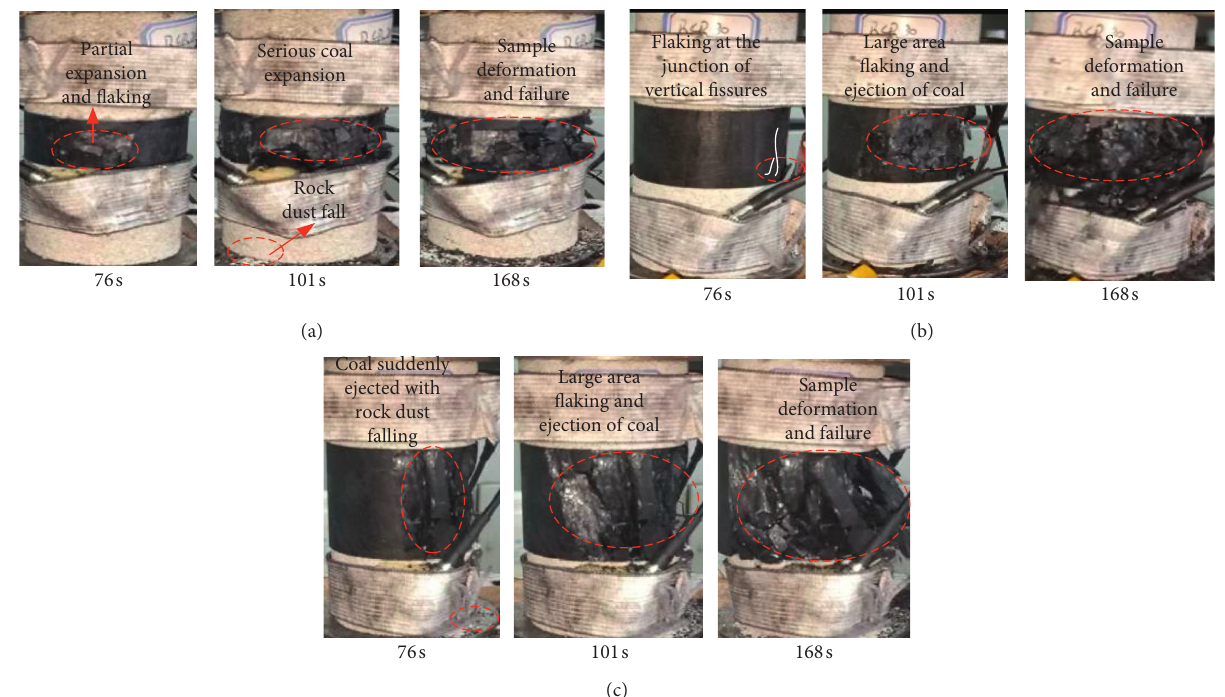
Figure 6: Destruction characteristics of the combined sample. (a) C-1 sample. (b) D-1 sample. (c) E-1